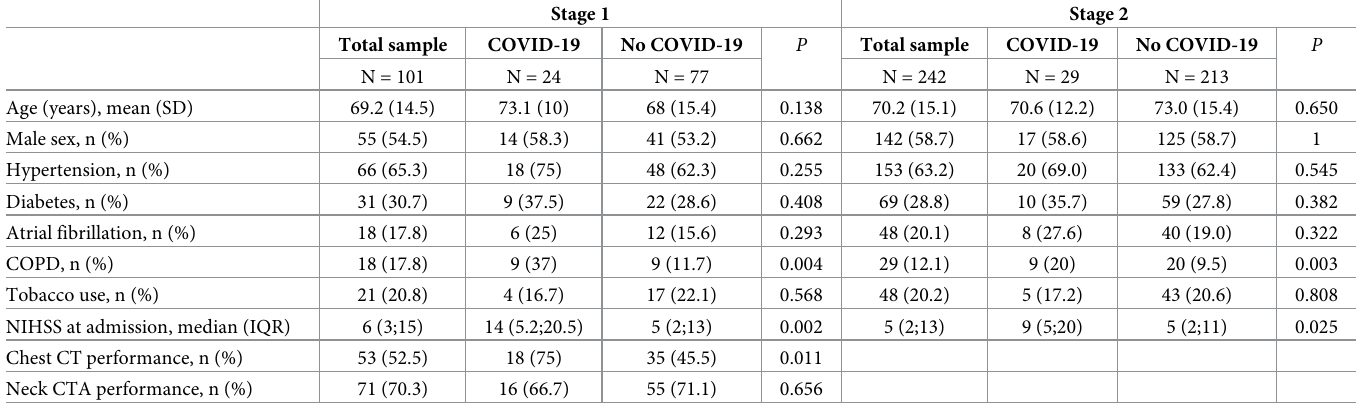
included 242 patients with acute stroke who underwent neck CTA (29 with PCR-confirmed Table 1. Demographics and baseline data in stage 1 and stage 2